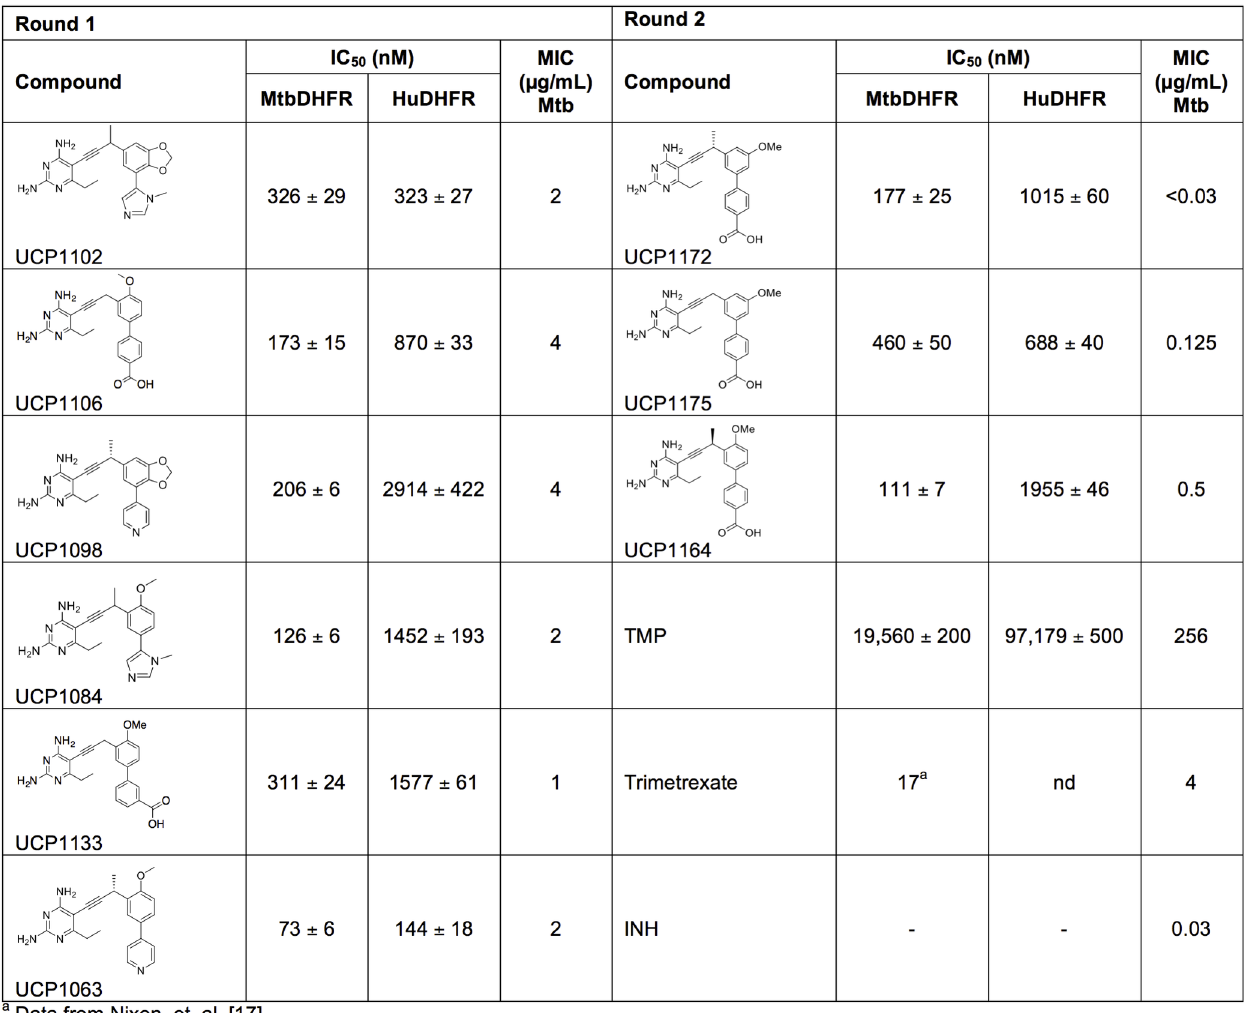
Fig 2. Evaluation of enzyme inhibition and antibacterial activity of propargyl-linked antifolates.